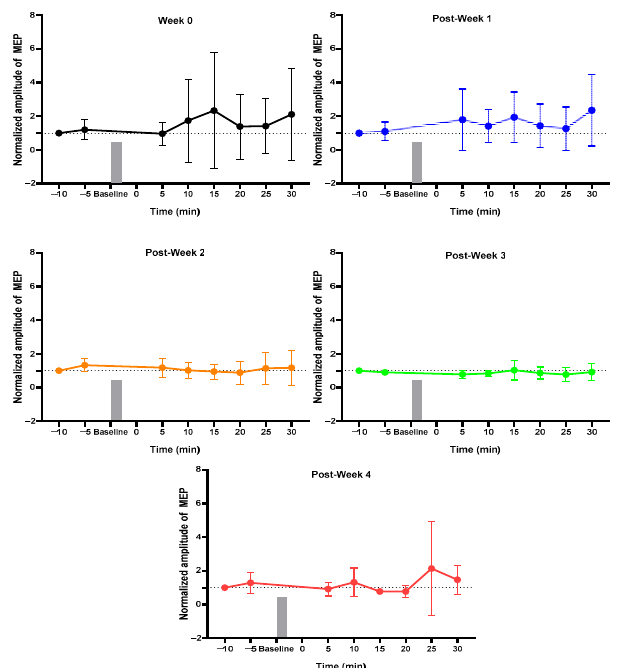
Figure 1. Normal ( n = 4): Normal group. Week 0, first week; Post ‐ Week 1, MEP after one week of wheel training; Post ‐ Week 2, MEP after two weeks of wheel training; Post ‐ Week 3, MEP after three weeks of wheel training; Post ‐ Week 4, MEP after four weeks of wheel training.